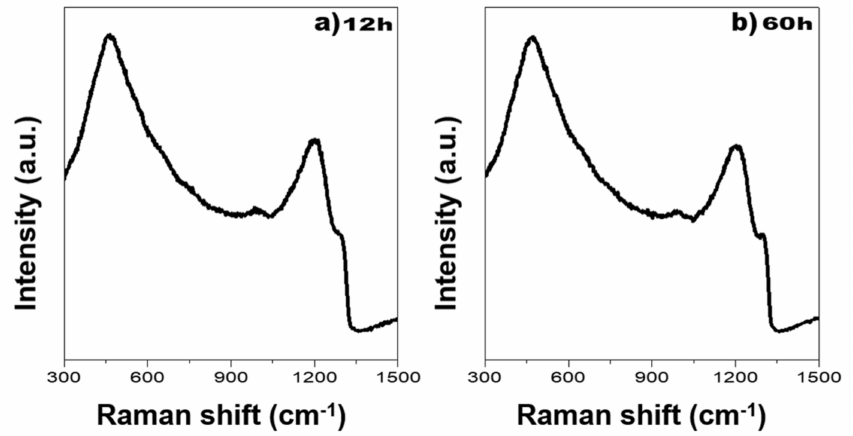
Figure 4. Raman spectra of BDD films deposited for ( a ) 12h and ( b ) 60